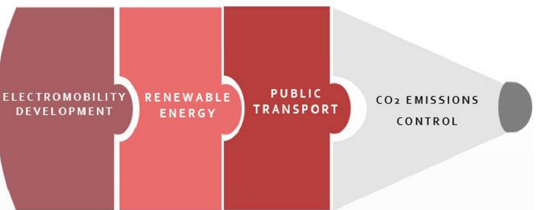
Figure 7. Main determinants of decarbonization according to the respondents with sustainability goals (SDG). Source: Own research based on the results of an online survey, n =